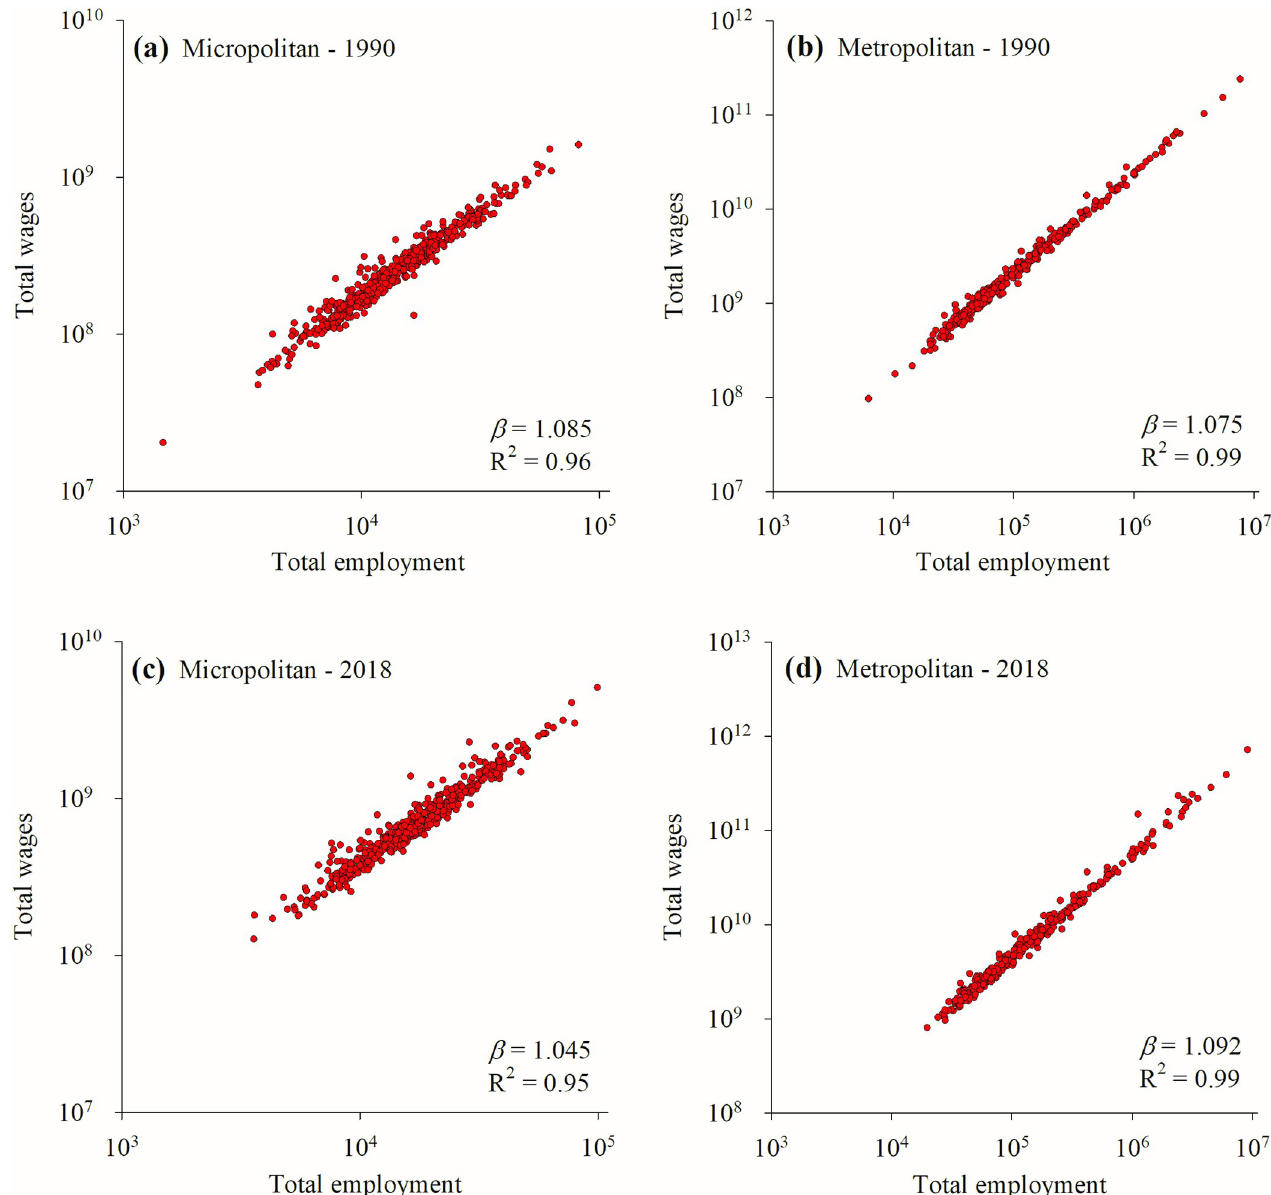
Fig 1. Scaling of total wages versus total employment. Power law regressions for four sample data sets are presented: Metropolitan and micropolitan areas for 1990 and 2018. The scaling coefficients determined in each regression correspond to single data points in Fig 2.